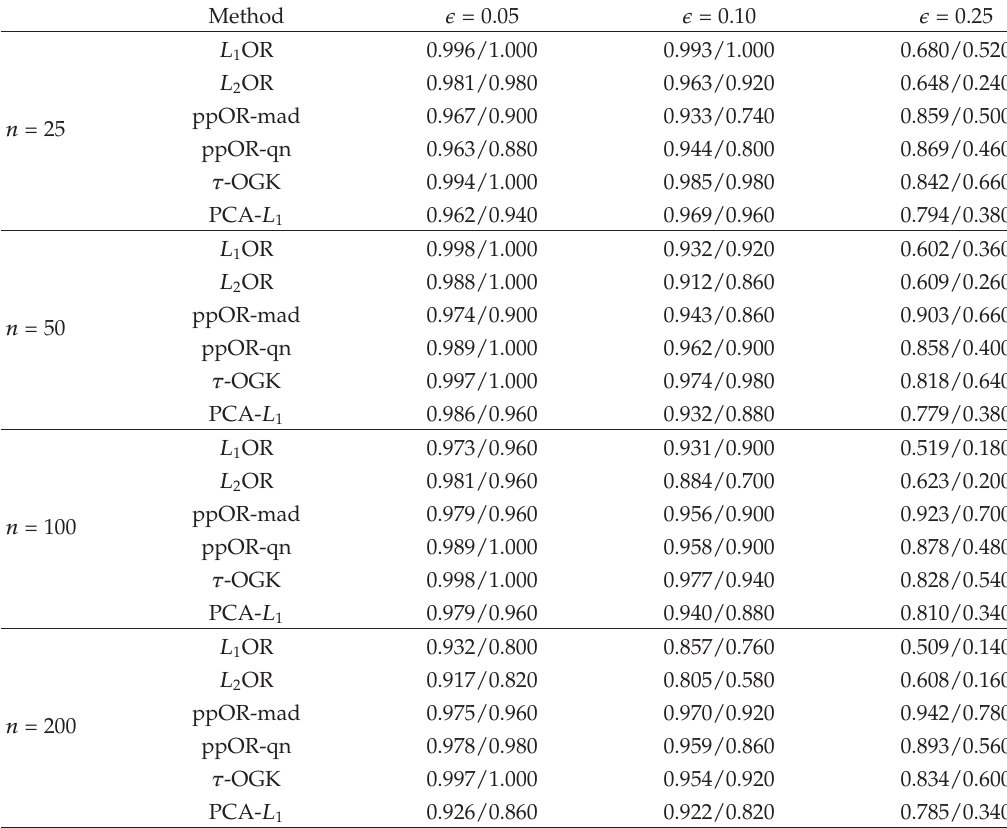
Table 2: Mean of S /percentage of instances with S ≥ 0 . 9 for L 1 OR, L 2 OR, ppOR-mad, ppOR-qn, τ -OGK, and PCA- L 1 with sample sizes n (cid:8) 25, 50, 100, and 200 and contamination levels (cid:3) (cid:8) 0 . 05 , 0 . 10, and